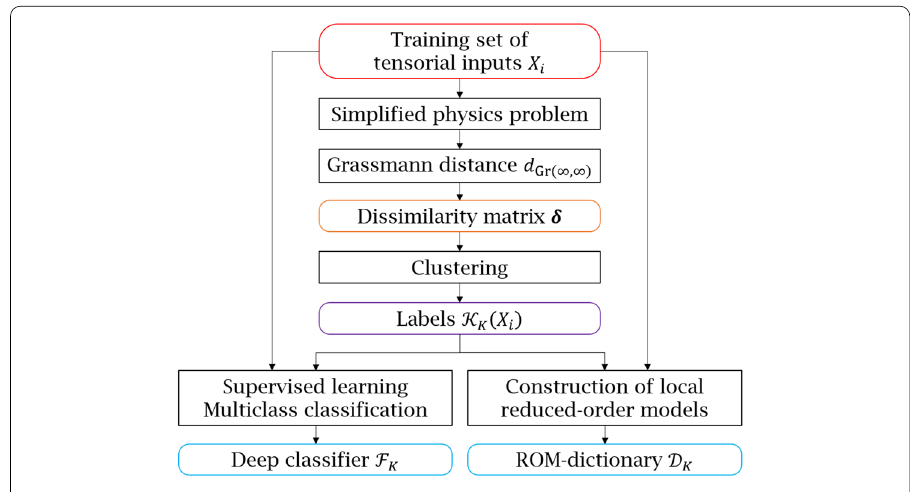
Fig. 3 Workflow for the training of a dictionary-based ROM-net